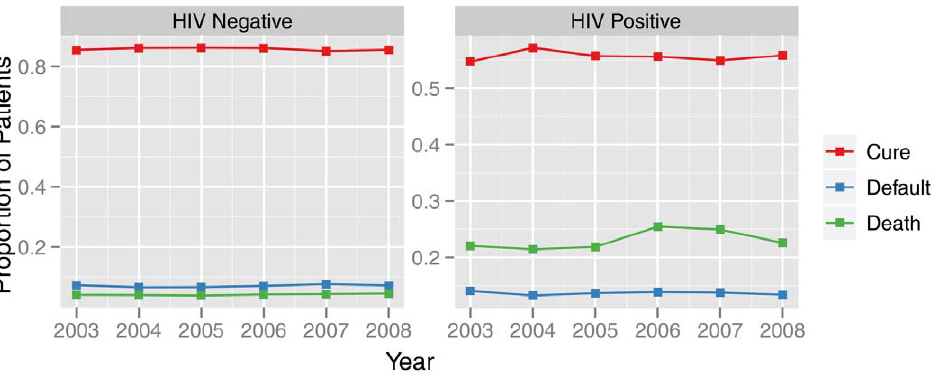
Figure 1. Treament outcomes (cure, default and death) for new TB cases by HIV status, Brazil 2003–2008. This figure shows the proportion of new TB cases and their outcomes, by year, during the study period. It demonstrates that these proportions remain stable, at different levels for each of the outcomes, over the 6-year period, for both HIV positive and HIV negative patients. It also highlights the differences by HIV status, especially regarding cure and death